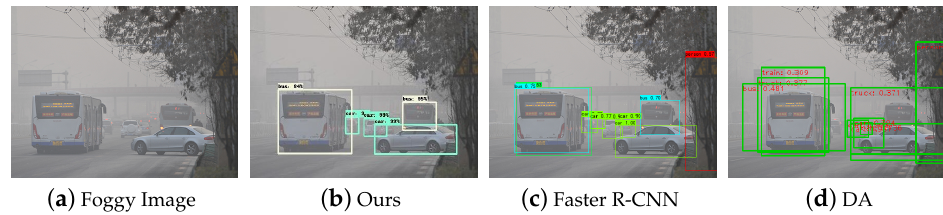
Figure 2. The detection effect in the real world. ( a ) indicates original image with fog; ( b ) indi- cates defogged image by our proposed method; ( c ) indicates defogged image by Faster RCNN [14]; ( d ) indicates defogged image by DA (Domain Adaptive)